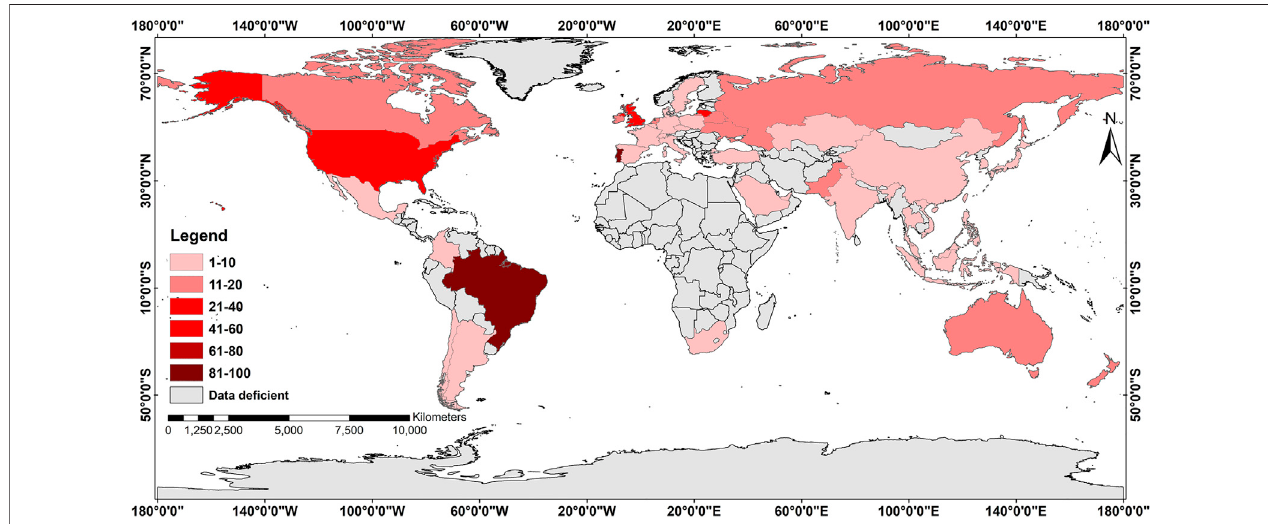
FIGURE 1 | Worldwide exploration of Lamiaceae for ethnopharmacological evaluations and other use. (Figure Source: The Authors and the fi gure is made using ArcGIS Pro